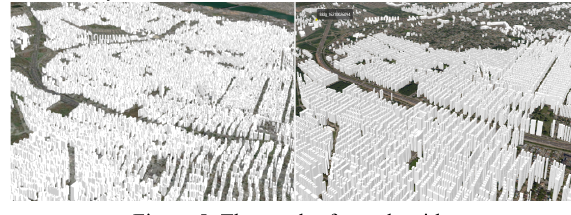
Figure 5: The result of our algorithm Figure 6: The result of